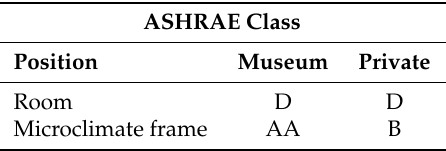
Table 2. Attribution of the ASHRAE class of climate control in the four